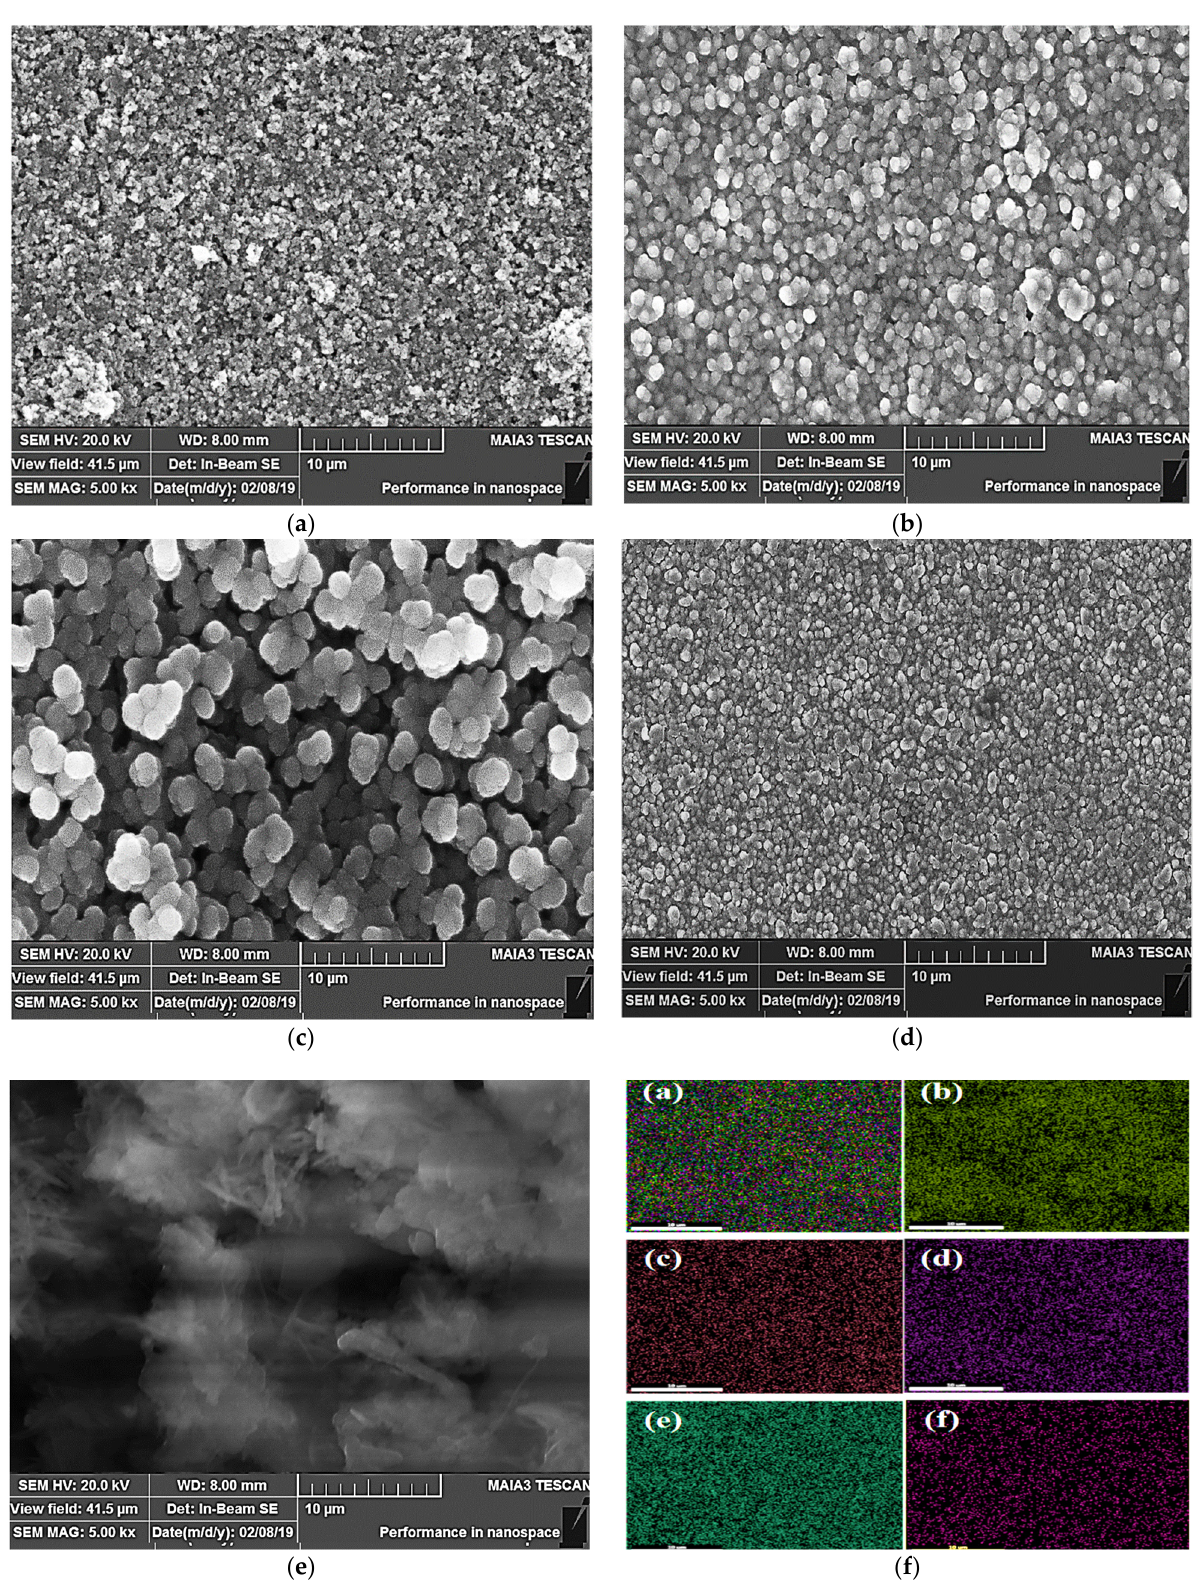
Figure 4. SEM micrographs of (a) pristine (b) radiation dose of 2.25x10 15 (c) 5.0x10 15 (d)7.25x10 15 (e) 1.0x10 16 ions/cm 2 and (f) EDS elemental composition of (a) Composite (b) O 2 (c) Co (d) Mn (e) Ni (f) Cl.